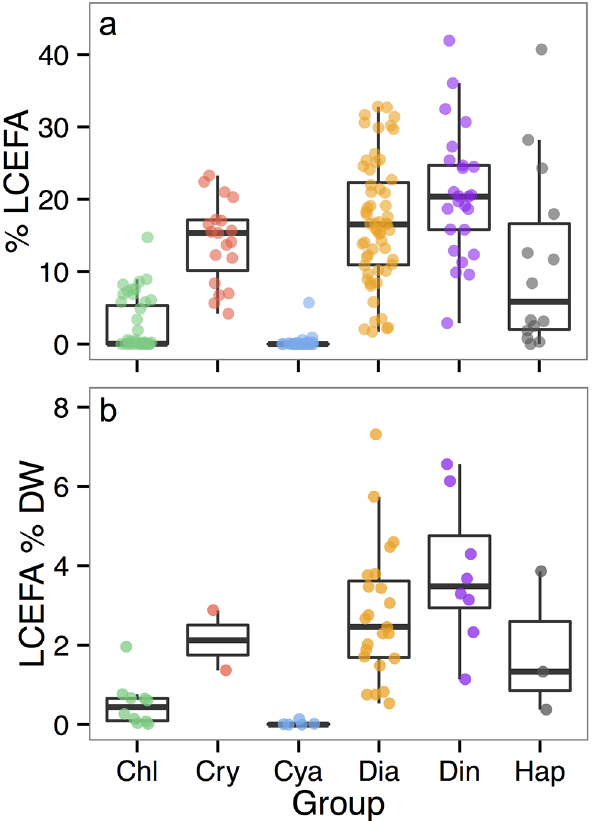
Fig 4. Boxplots of species averages of Σ long-chain essential fatty acids (LCEFA) in six major phytoplankton groups. (a) Shows the % FA dataset, consisting of 208 averages from 666 raw profiles. (b) Shows the FA % DW dataset, consisting of 55 averages from 105 raw profiles. Group name abbreviations follow Fig 1. The heavy line is the median, box boundaries are the 25 th and 75 th percentiles, and whiskers extend to the most extreme value within 1.5 * IQR (interquartile range). The y-axis is set to show the extent of whiskers, thus some extreme outliers are not plotted (outliers were included in calculation of average group